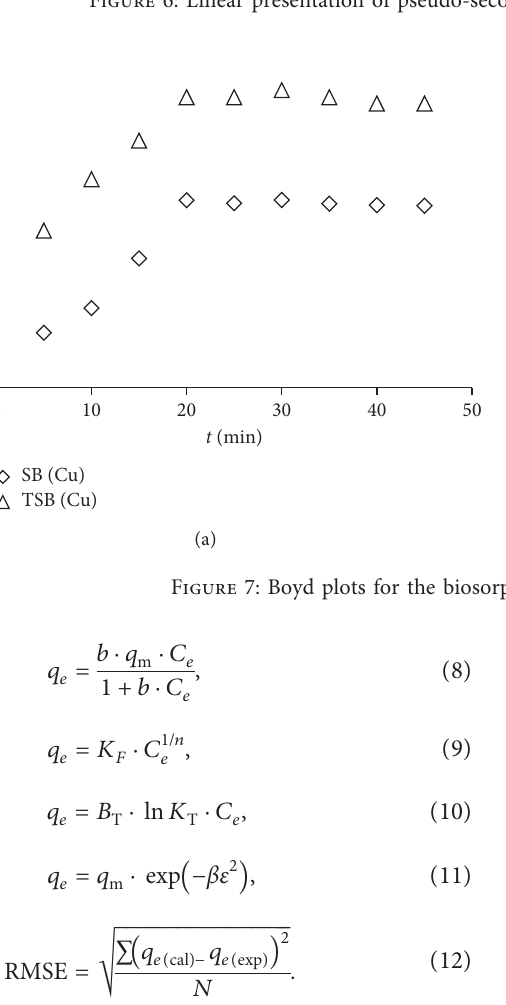
Figure 6: Linear presentation of pseudo-second-order graph: (a) Cu(II) and (b) Cd(II).